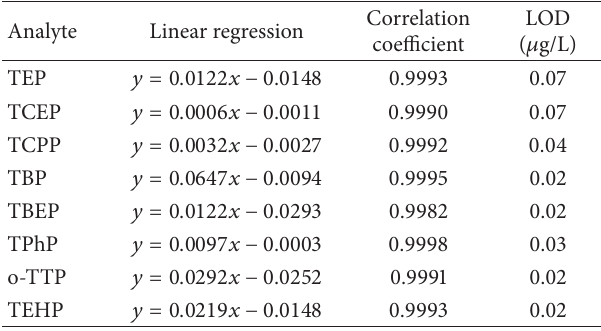
Table2:Equationsoflinearcorrelation,correlationcoefficients,and method detection limits (LOD) of